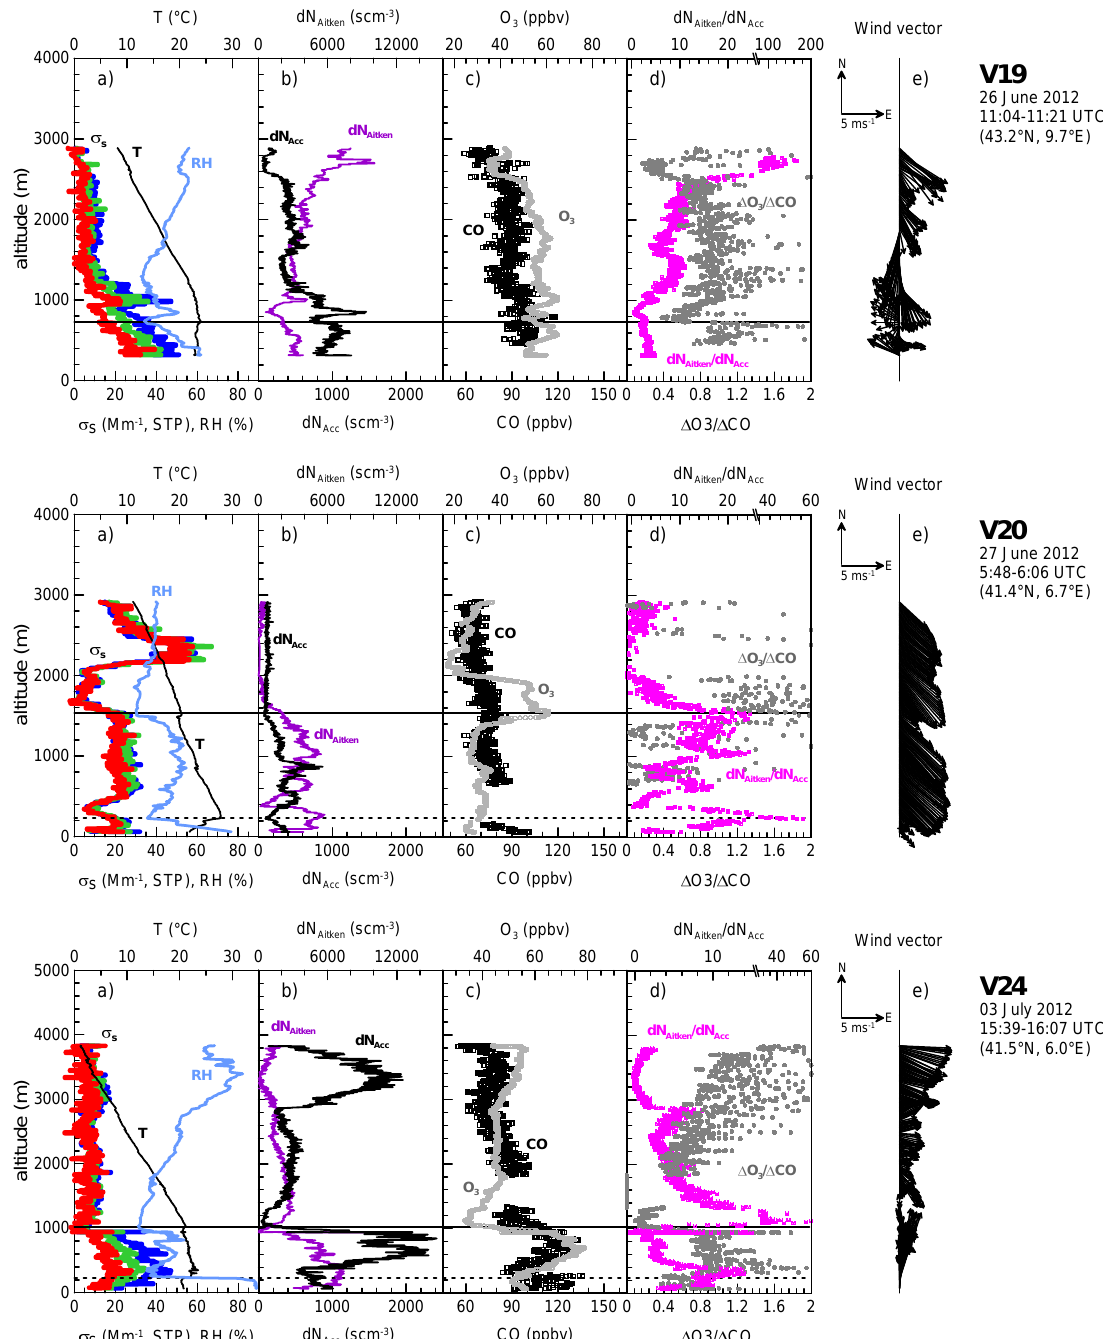
Figure 8. Aerosol and trace gases vertical profiles for flights V19 (export from northern Italy/Po Valley), V20 (mistral event), and V24 (export from the Barcelona area). The plots show the (a) spectral scattering coefficient σ s at 450, 550, and 700nm (blue, green, and red lines, respectively), temperature ( T , black line), and relative humidity (RH, light blue line); (b) particle number concentration in the 0.004–0.1µm (d N Aitken , purple line) and 0.1–1.0µm (d N Acc , black line) diameter ranges; (c) CO (black dots) and O 3 (grey dots) mixing ratios; (d) ozone enhancement factor (cid:49) O 3 / (cid:49) CO (grey dots) and Aitken-to-accumulation ratio d N Aitken / d N Acc (pink dots); and (e) horizontal wind vector. The heights of the top of the MABL (dotted line) and BL (solid line) are also